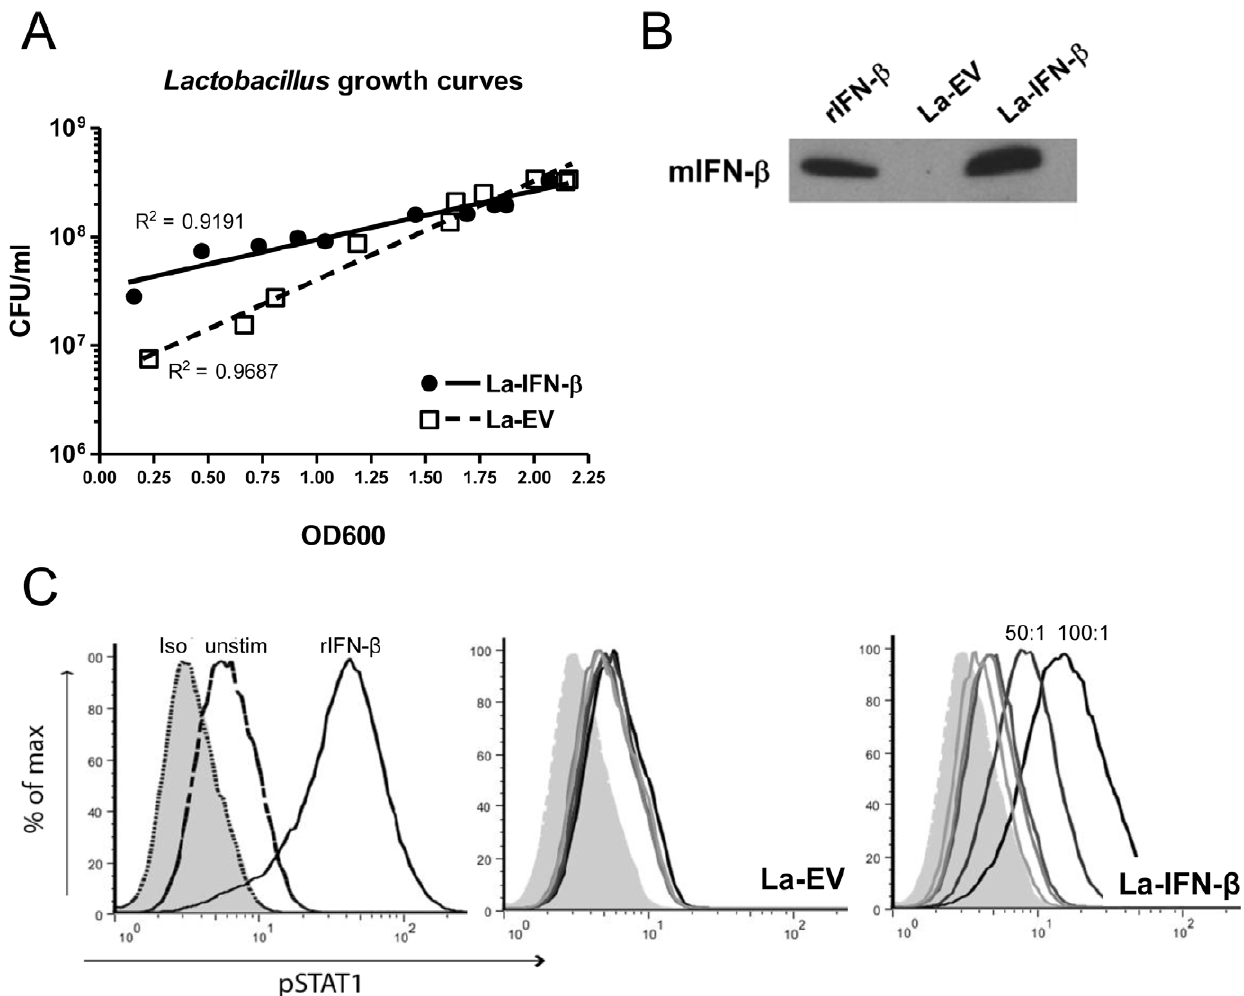
Figure 2. La-IFN- b expresses biologically functional murine IFN- b . ( A ) Growth curves for La-IFN- b and La-EV strains correlating CFU/ml of bacterial culture with OD600 values. ( B ) Western blot showing detection of murine IFN- b in the supernatant from an overnight culture of transgenic La-IFN- b . Prior to Western blotting, the protein was precipitated using TCA. Positive control is 100 U of recombinant murine IFN- b . ( C ) Phosphorylation of STAT1 in a C57BL/6 macrophage cell line after 60 min stimulation with rIFN- b (1000 U) as a positive control or co-culture with 5:1, 10:1, 50:1 or 100:1 ratios of La-EV or La-IFN- b .